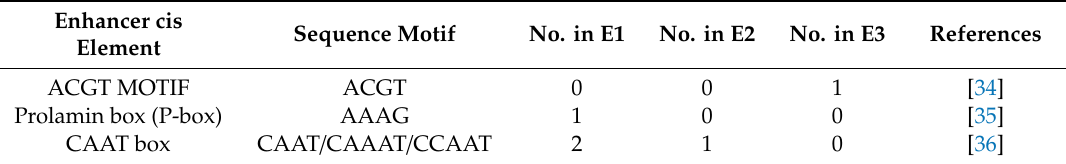
Table 3. Enhancer motif analysis of E1, E2, and